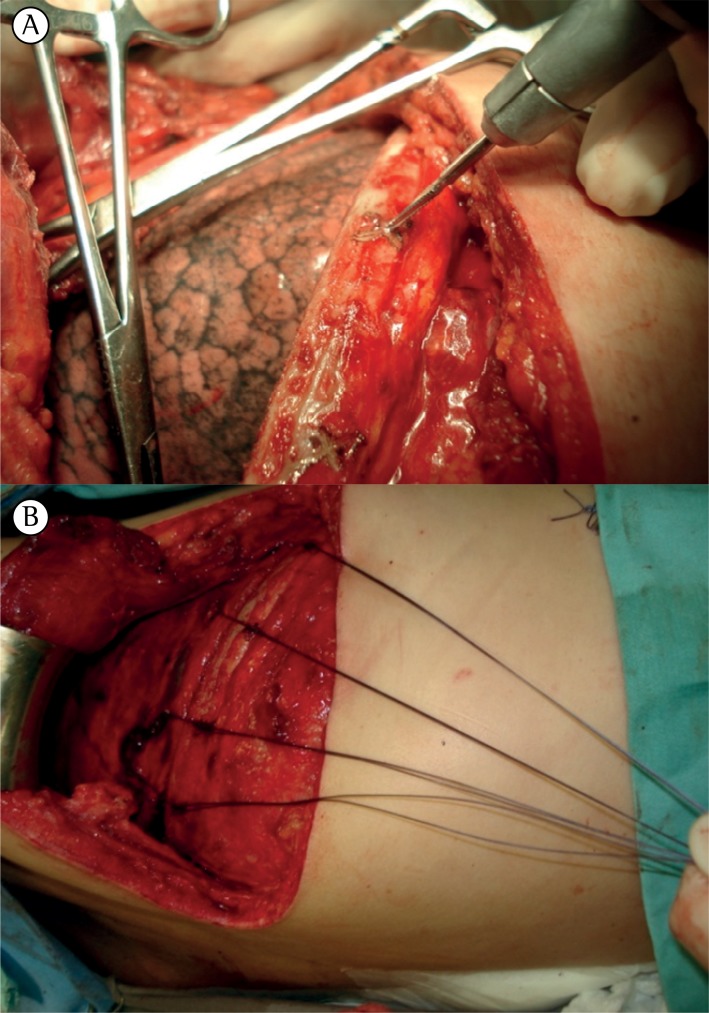
Em A, perfuração da costela através da broca. Em B, aproximação do
quinto e sexto arco costal após a passagem do fio de sutura pelos forames
realizados pela broca.